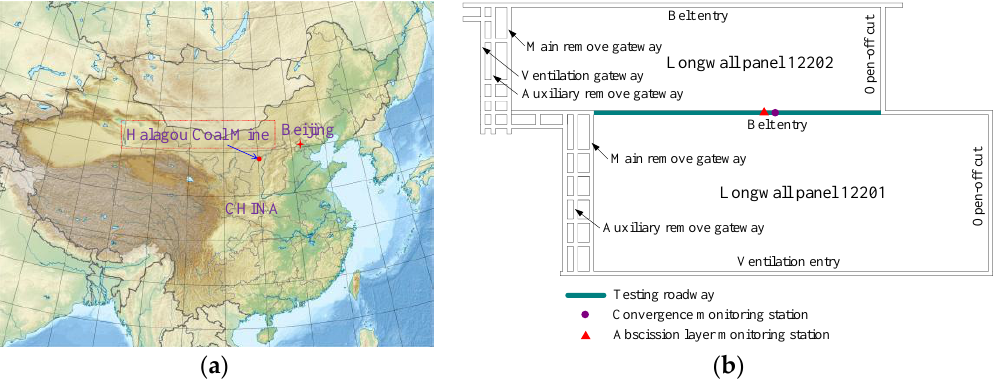
Figure 1. ( a ) The location of the Halagou coal mine, Shanxi, China; ( b ) Plane layout of the mining panel.